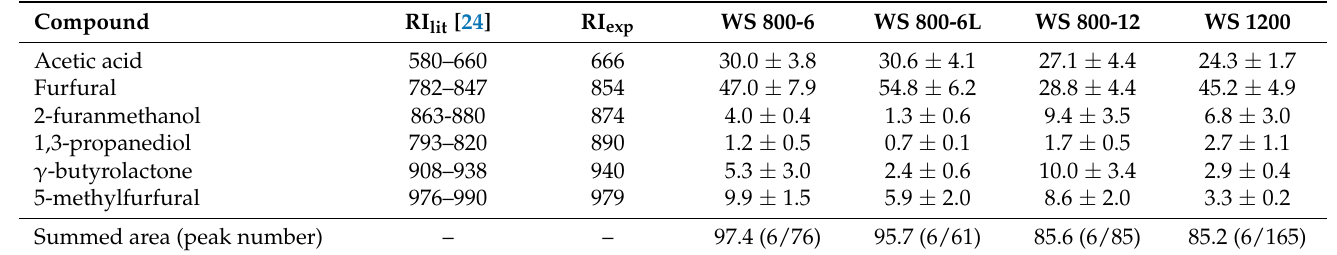
Table 3. The most abundant identified VOCs and their relative area % from the total peaks in